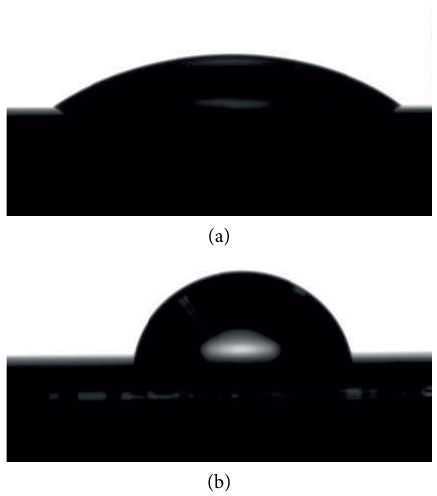
Figure 1: Water contact angle on (a) silica and (b) asphaltene